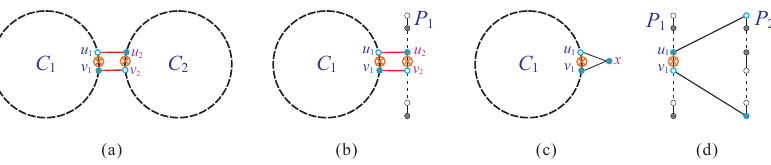
Figure 6. A schematic diagram for ( a ) Statement (1), ( b ) Statement (2), ( c ) Statement (3), and ( d ) Statement (4) of Proposition 1, where the bold dashed lines indicate the cycles (paths) and ⊗ represents the destruction of an edge while constructing a cycle or